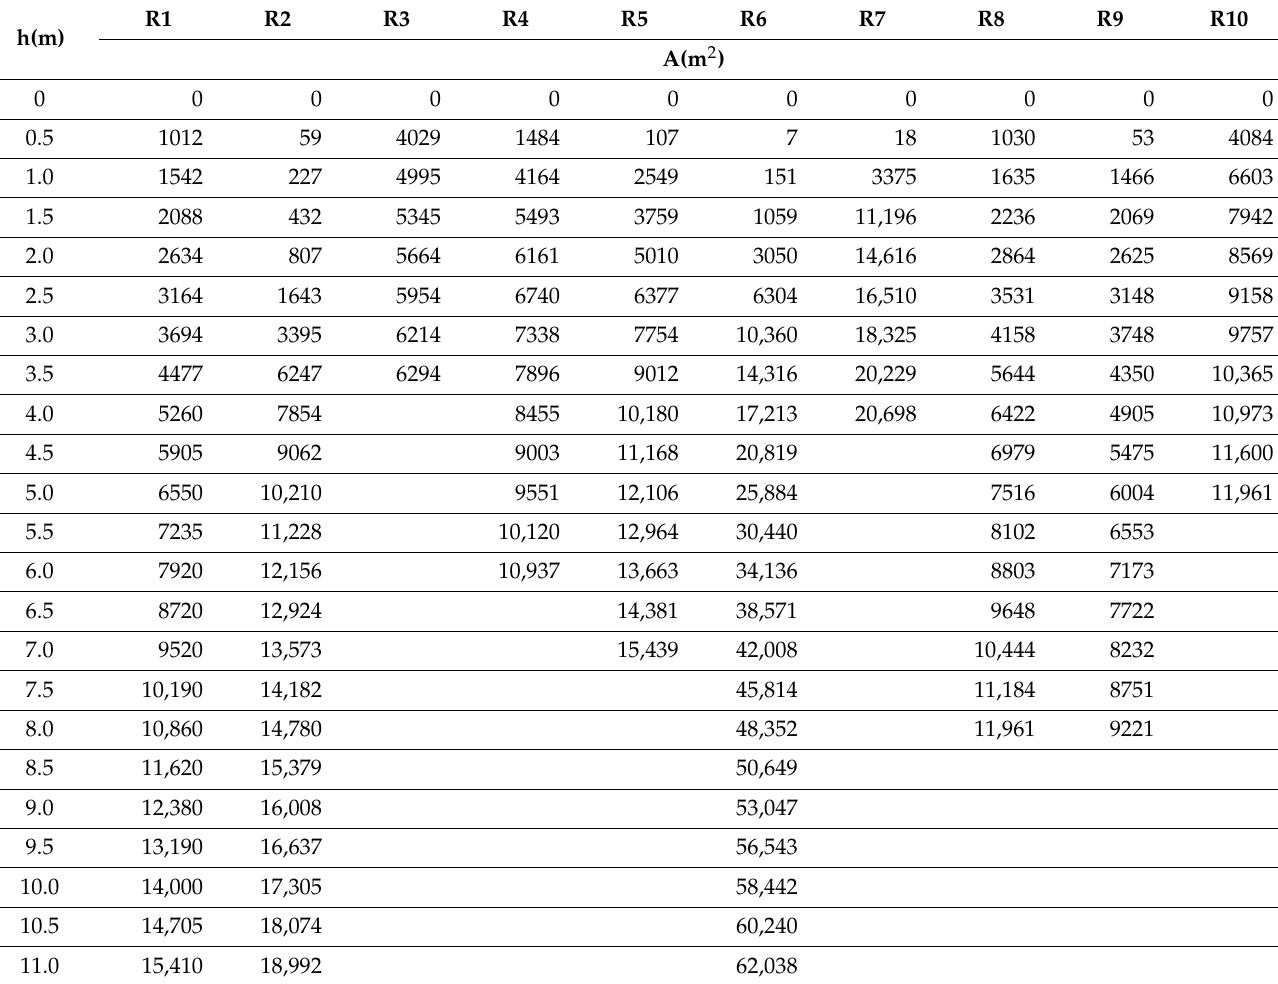
Table 2. Area estimations according to the change in reservoir